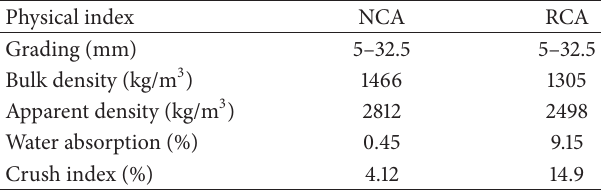
Table 1: Physical properties of NCA and RCA.